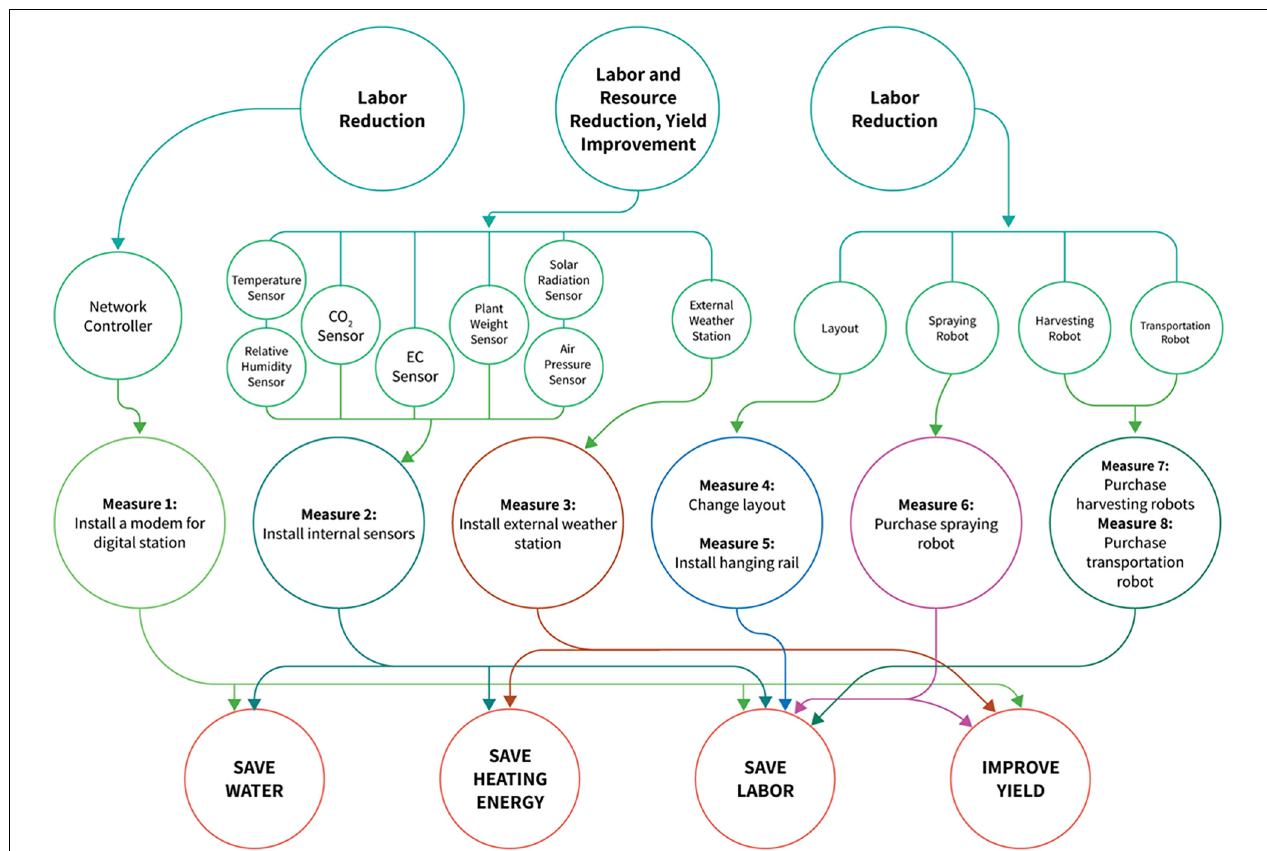
FIGURE 3 | Retrofitting procedures, their interactions, and potential